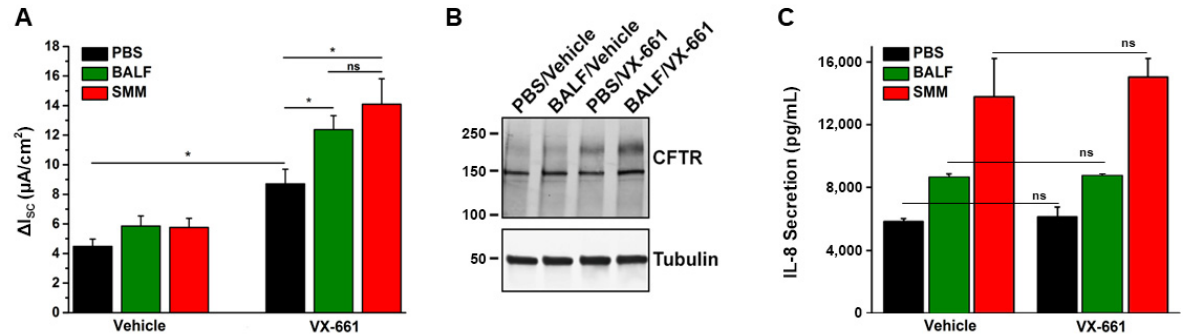
Figure 2. Exposure of CF HBE to pediatric BALF enhances F508del CFTR rescue. ( A ) CFTR responses from F508del/F508del HBE cultures evaluated in Ussing chambers. Cultures were apically exposed to 30 µ M BALF or SMM and serosally treated with vehicle or 5 µ M VX-661. Data are expressed as mean ± SEM. ns = not significant; 2 donors, five to six cultures/experimental group. ( B ) Representative CFTR Western blot to analyze F508del maturation (upper band); ( C ) IL-8 secretion (pg/mL of culture media) from the F508del/F508del HBE evaluated in ( A ). * p < 0.05. Data are expressed as mean ± SEM. Modified from Gentzsch et al., 2021 [32] .